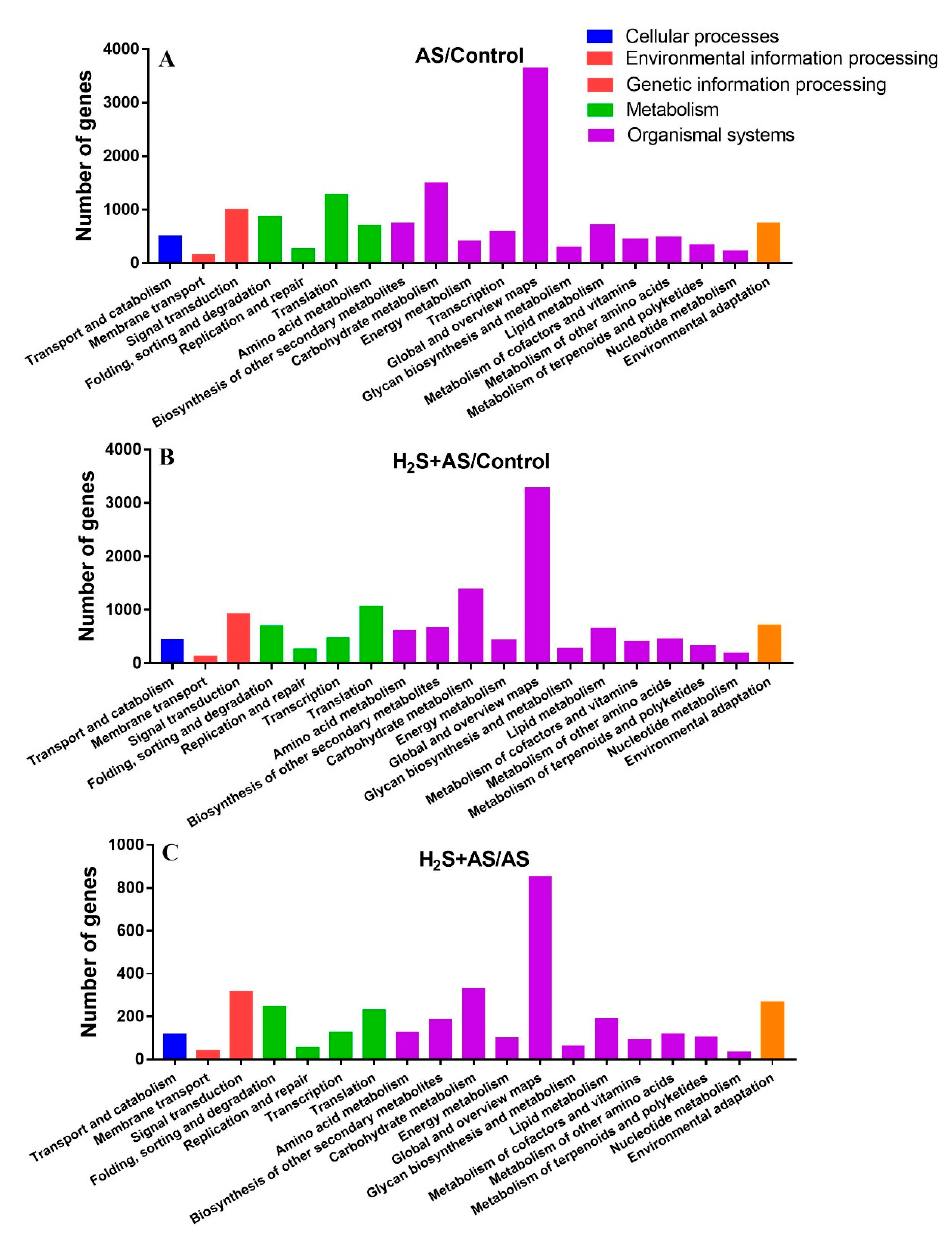
Figure 4. KEGG pathway of differentially expressed genes. Blue, red, green, purple, and orange represent the different KEGG pathways: cellular processes, environmental information processes, genetic information processes, metabolism, and organism systems.